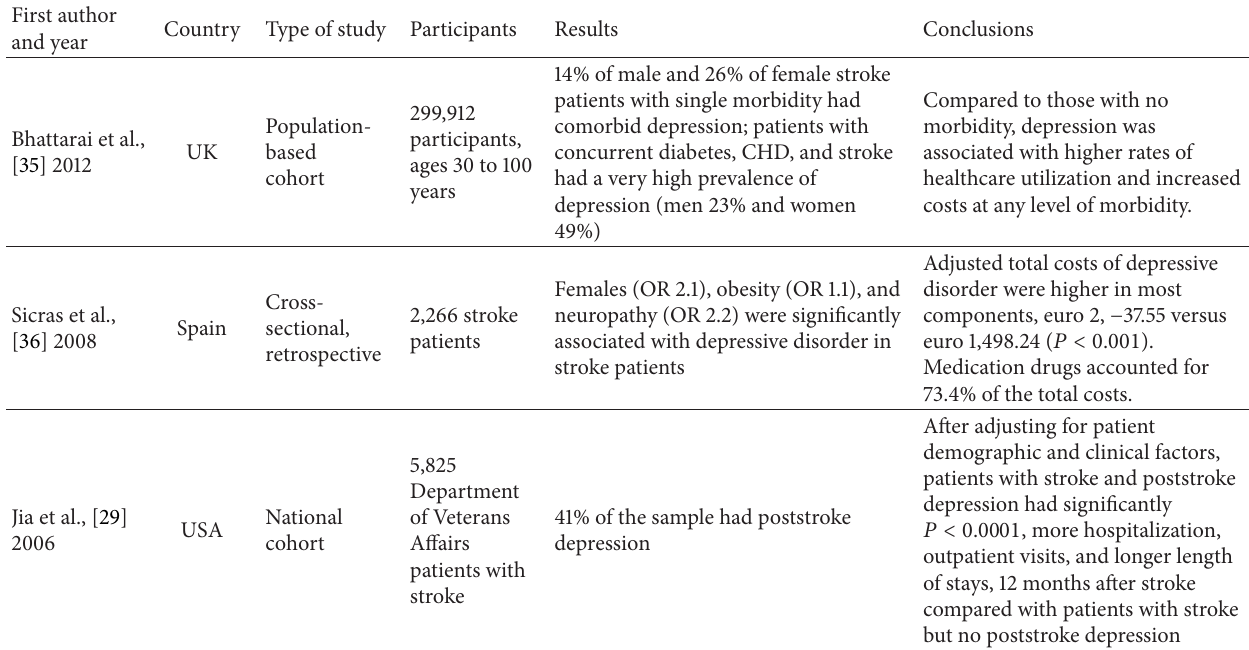
Table 3: Increased medical care costs of stroke associated with depression. Recent peer-reviewed